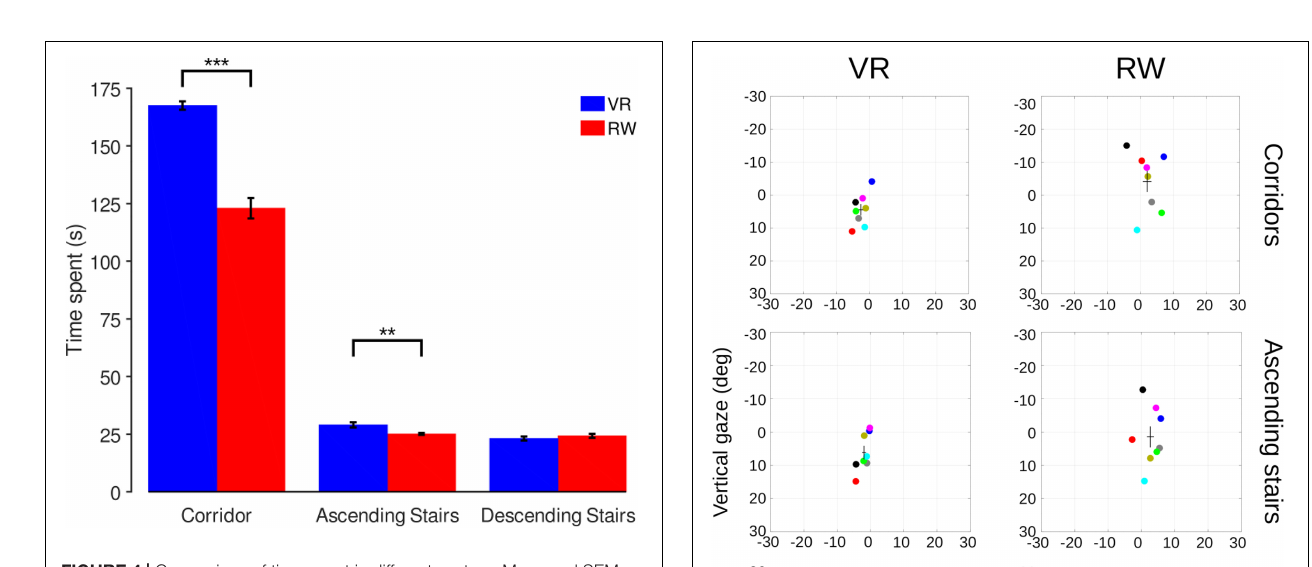
FIGURE 4 | Comparison of time spent in different sectors. Mean and SEM across participants, with significant differences indicated above (*** p < 0.001, ** p < 0.01).